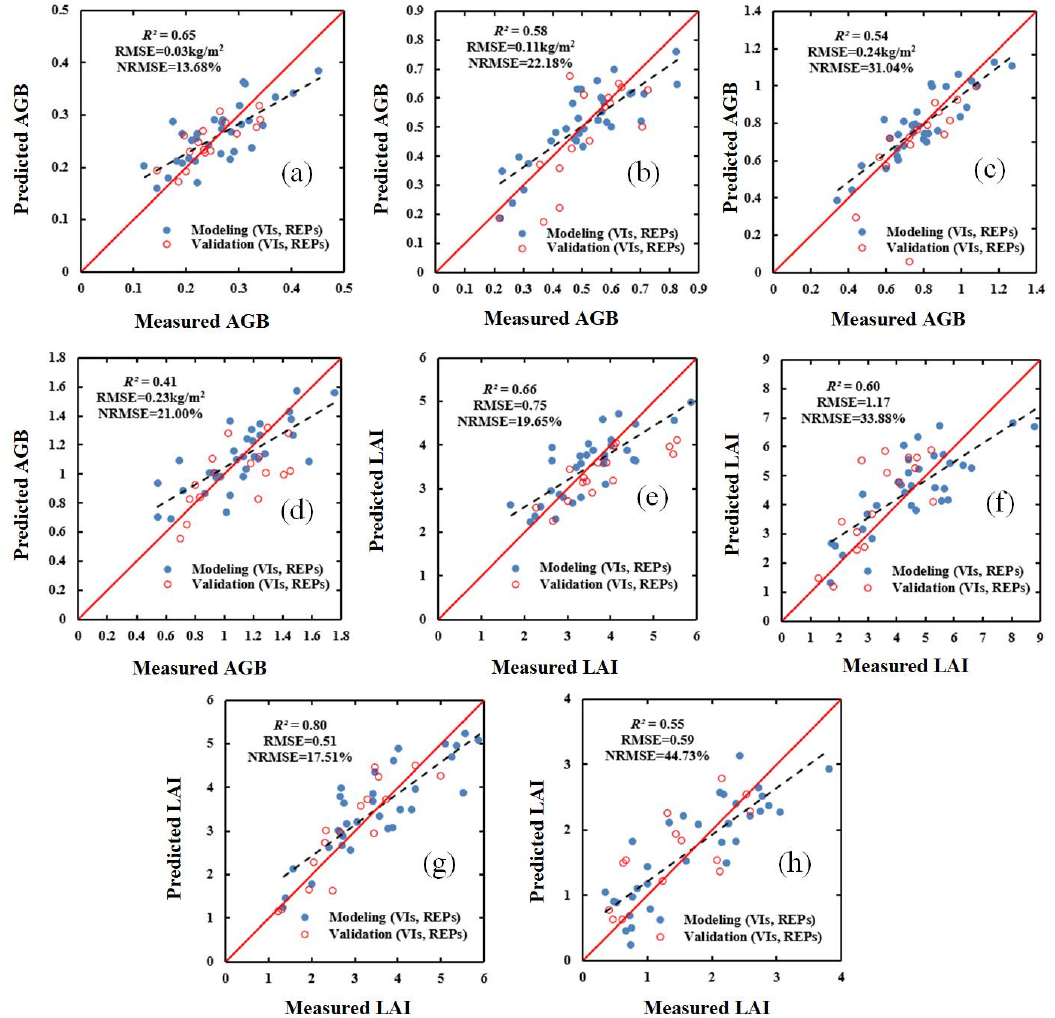
Figure 5. Relationship between ground-measured values of AGB (kg/m 2 ) and LAI (m 2 /m 2 ) in different growth stages of winter wheat and the values based on a combination of VIs and red-edge parameters (RPs) and SWR: ( a ) AGB (jointing stage); ( b ) AGB (flagging stage); ( c ) AGB (flowering stage); ( d ) AGB (filling stage); ( e ) LAI (jointing stage); ( f ) LAI (flagging stage); ( g ) LAI (flowering stage); ( h ) LAI (filling stage).